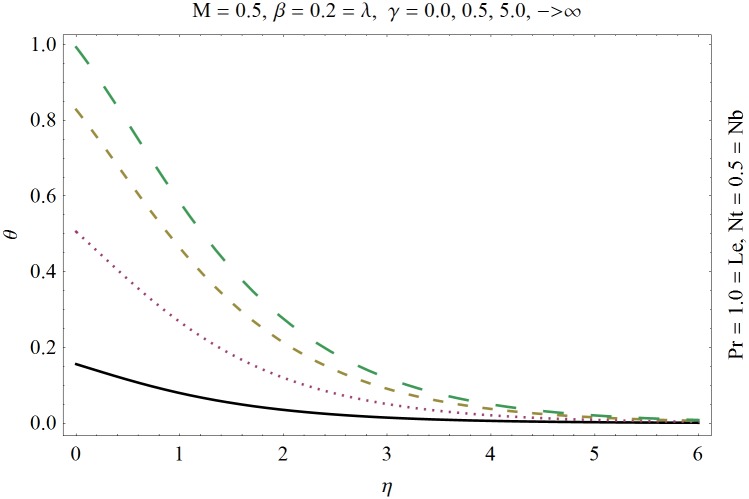
Influence of Biot number γ on θ.